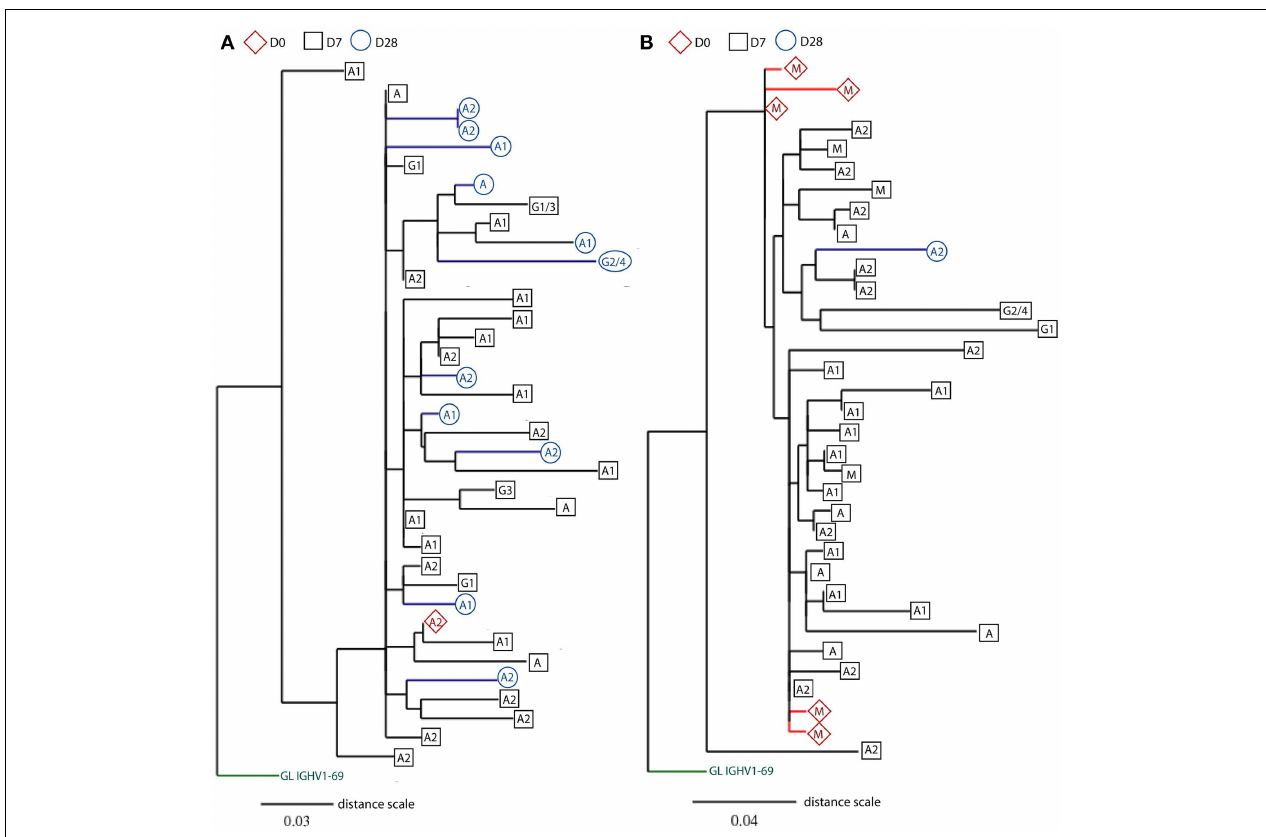
trees in green.The class (IgG, IgA, and IgM) or subclass (indicated by numbers) of IGH genes is indicated in the shapes. Internal nodes represent hypothetical intermediates of IGH sequences, and the branch lengths indicate percentage mutation differences between IGH sequences in proportion to the distance scale. Only two illustrations of phylogenetic trees are shown (A) from an old donor aged 71years and (B) from a young donor aged 22years. For space consideration, sequences in the two clones are randomly chosen for